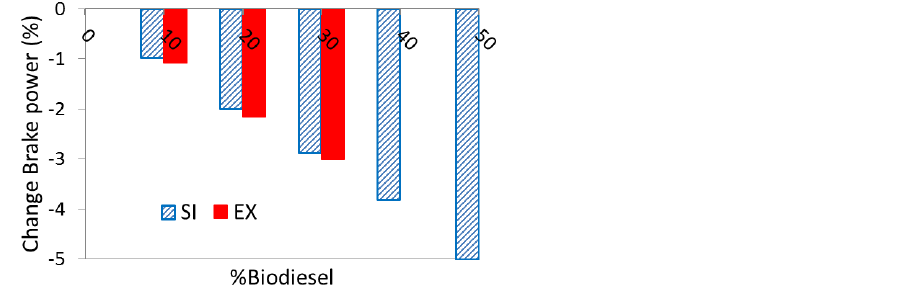
Figure 9. Trend of capacity changes according to biodiesel blend ratio of simulation (SI) and ex- periment (EX).